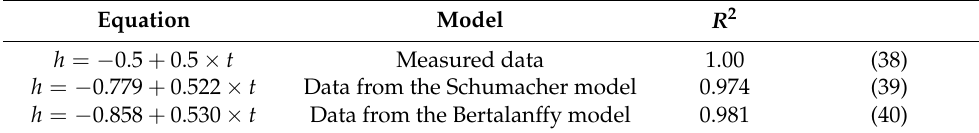
Table 11. Linear models for the height versus age projections for the data obtained by measurement and for the data obtained through the application of the Schumacher and Bertalanffy models.